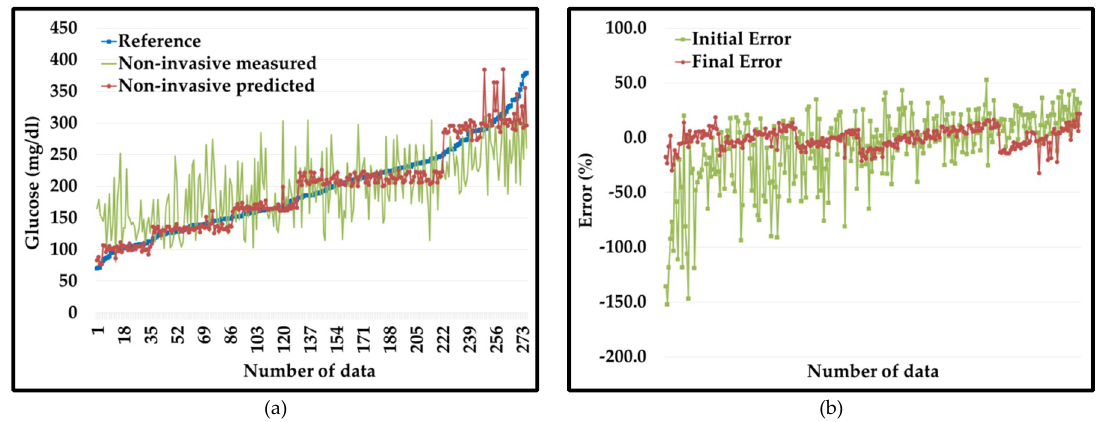
Figure 4. ( a ) Non-invasive measured (in green color) vs. non-invasive predicted (in red color) with respect to reference values (in blue color). ( b ) Percentage error non-invasive measured (in green color) vs. non-invasive predicted (in red color) for dataset 1.